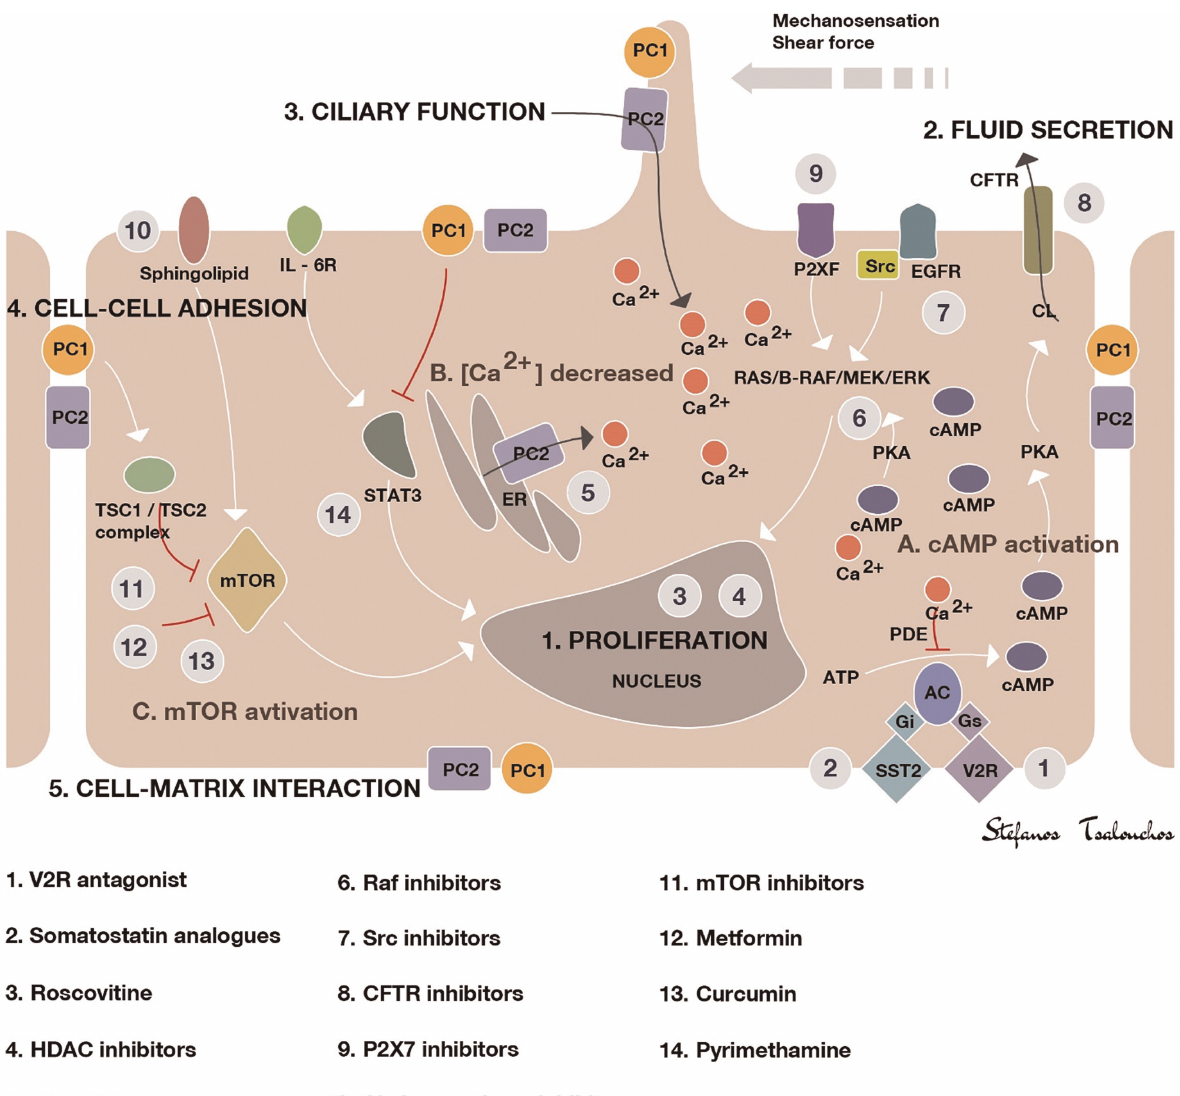
Figure 1. Illustration of the key mechanisms of ADPKD pathogenesis and targets of potential treatments. Polycystin-1 and polycystin-2 expressed in different subcellular locations and regulate (1) proliferation, (2) fl uid secretion, (3) ciliary function, (4) cell – cell adhesion, and (5) cell – matrix interaction of renal epithelial cells. Dysfunction of polycystin-1 or polycystin-2 results in aberrant signaling pathways, including: (A) activation of cAMP, (B) decreased intracellular calcium concentrations, and (C) activation of mTOR. The targets of candidate drugs are depicted as gray circles. Abbreviations: CFTR, cystic fi brosis transmem- brane regulator; ER, endoplasmic reticulum; ERK, extracellular signal-regulated kinase; GlcCer, glucosylceramide; HDAC, his- tone deacetylase; IL-6R, interleukin-6 receptor; MEK, mitogen-activated protein kinase; mTOR, the mammalian target of rapamycin; PC, polycystin; PDE, phosphodiesterase; PKA, protein kinase A; SR, somatostatin receptor; TSC, tuberous sclerosis; V2R, vasopressin V2